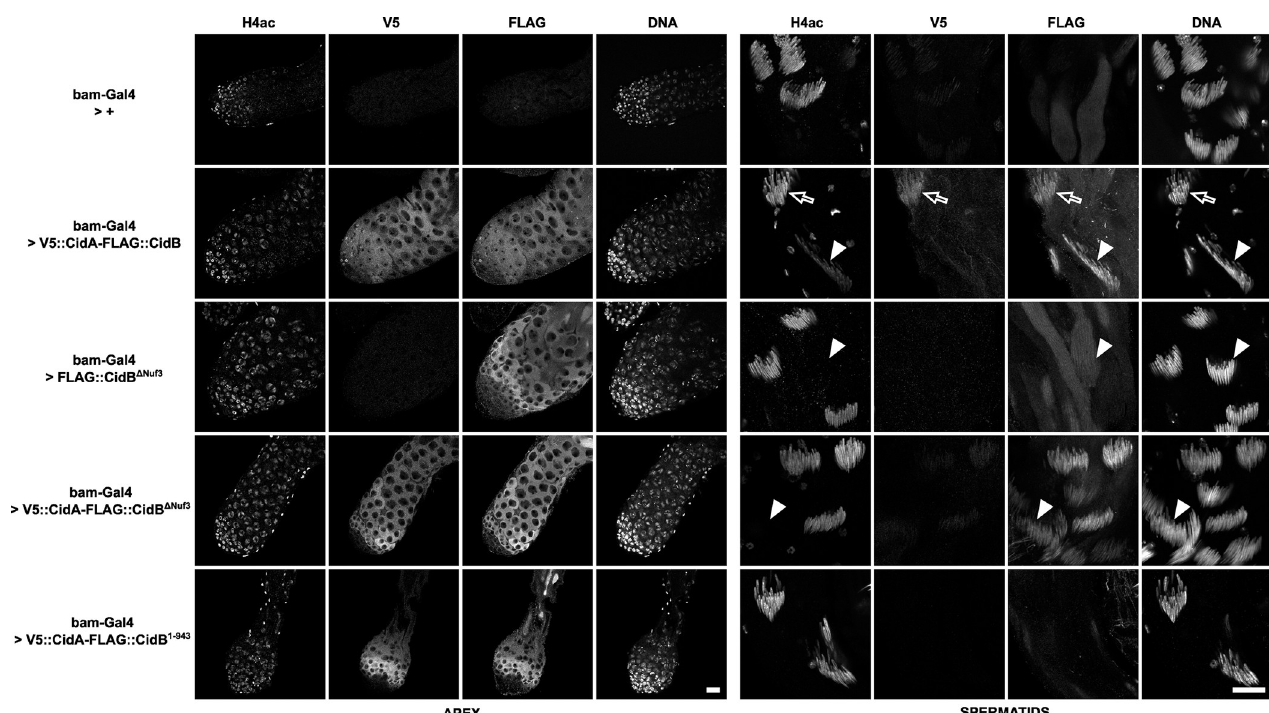
Fig 6. Spatial-temporal localizations of Cid effectors in transgenic D . melanogaster testes. Confocal images of D . melanogaster testes of the indicated genotypes. Apical region with proliferative germ cells is shown on the left and canoe stage spermatids on the right. The immunofluorescence stainings reveal from left to right for each zone of the testis the acetylated histone 4 -H4ac- lost during the histone-to-protamine transition, V5::CidA, Flag::CidB, and DNA stained with DAPI. Arrows indicate cysts positive for H4ac before the histone-to-protamine transition while arrowheads point toward post-transition cysts negative for H4ac. The first horizontal row is a negative control testis which only expresses bam -Gal4. The testis shown in the second row expresses wild-type tCidA and tCidB. Representative spermatid cysts still positive for histones (H4ac) are indicated with an arrow. Arrowheads show cysts after the histone-to- protamine transition. Scale bars = 20 μ